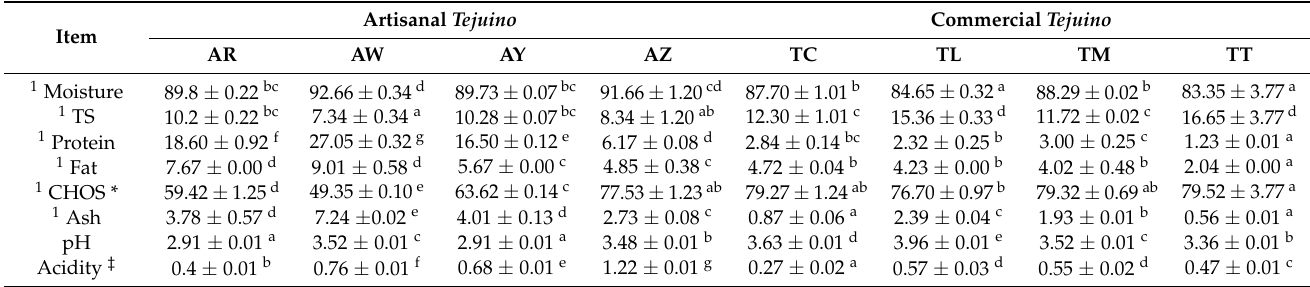
Table 1. Physicochemical composition of artisanal and commercial Tejuino beverages from Nayarit, Mexico. Artisanal Tejuino Commercial Tejuino